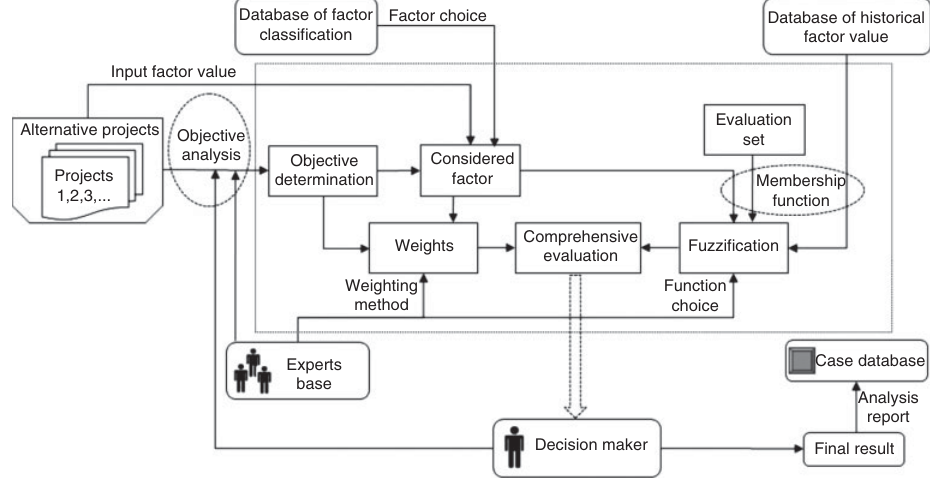
Fig. 6. Decision support system for urban rail transit